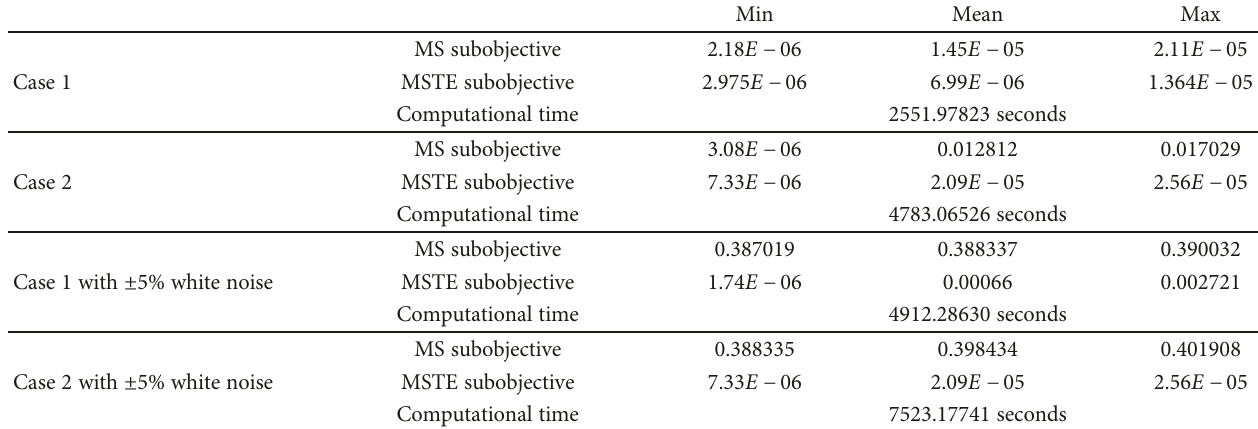
Table 1: Numerical evaluation of the MOLFPSO/TOPSIS with FE model